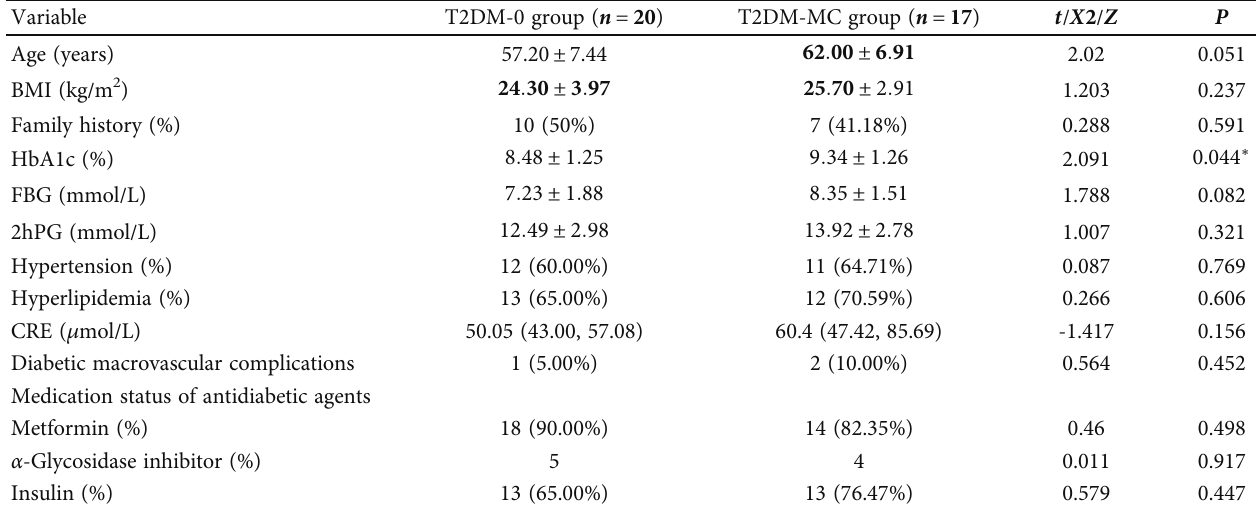
Table 2: Clinical characteristics of the patients.